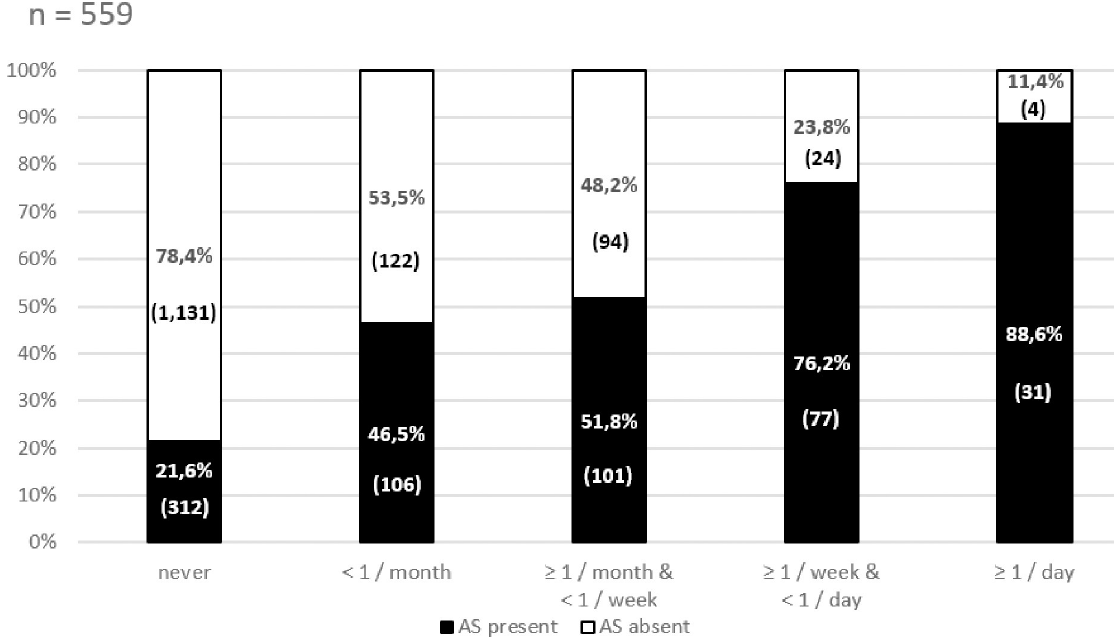
Fig 1. The occurrence of atypical symptoms in participants with typical GERD symptoms. There is a positive linear association between the frequency of the typical GERD-related symptom, and the presence of atypical symptoms (AS). (R 2 = 0.9748, P < 0.0001).